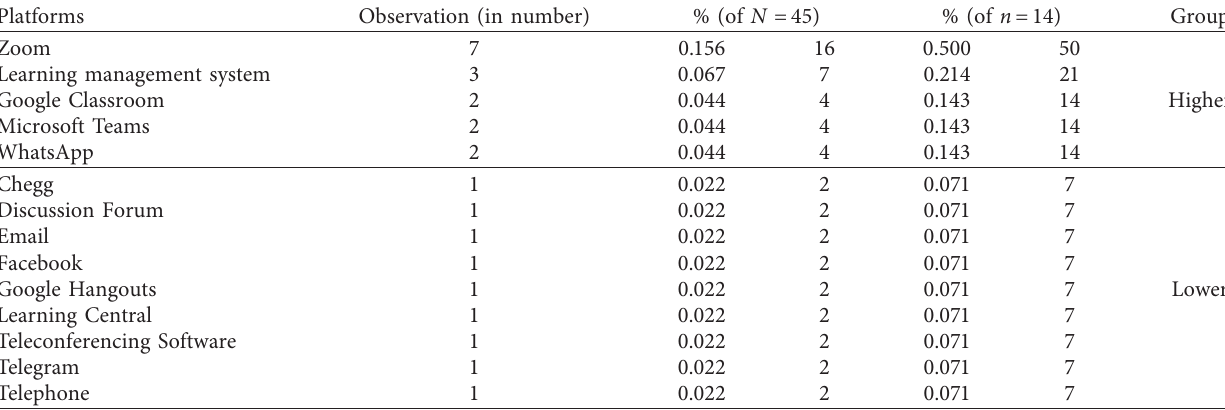
Table 10: Percentage of each platform used for online learning and their groups based on 50th quartile.